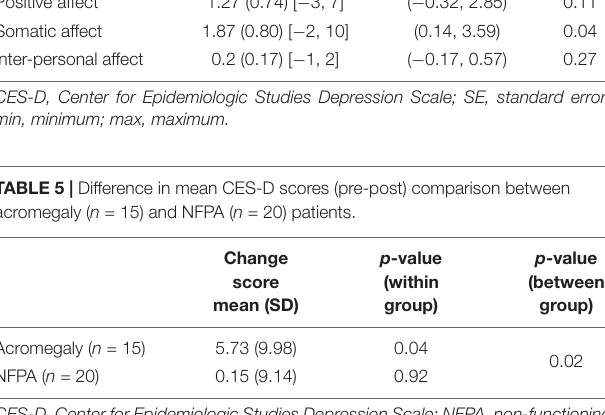
Change score mean (SD)